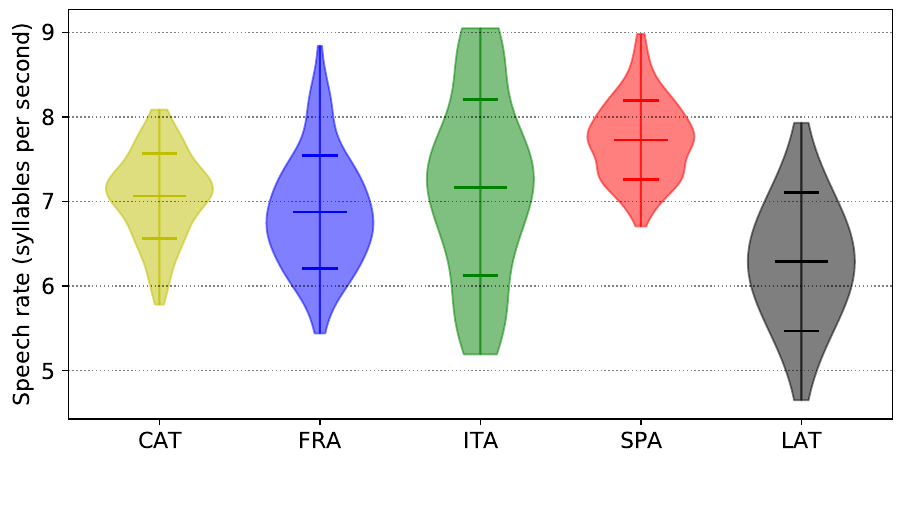
Figure 7. The speech rate of Classical Latin compared to modern Romance languages: Catalan, French, Italian, and